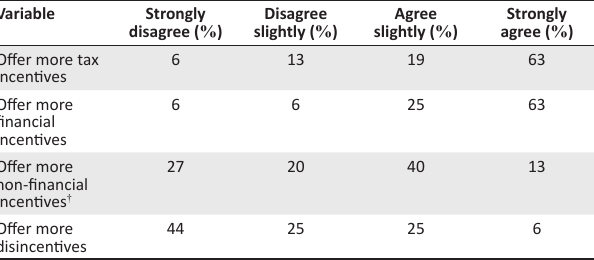
TABLE 7: Claiming the available tax incentives in South Africa. Variable